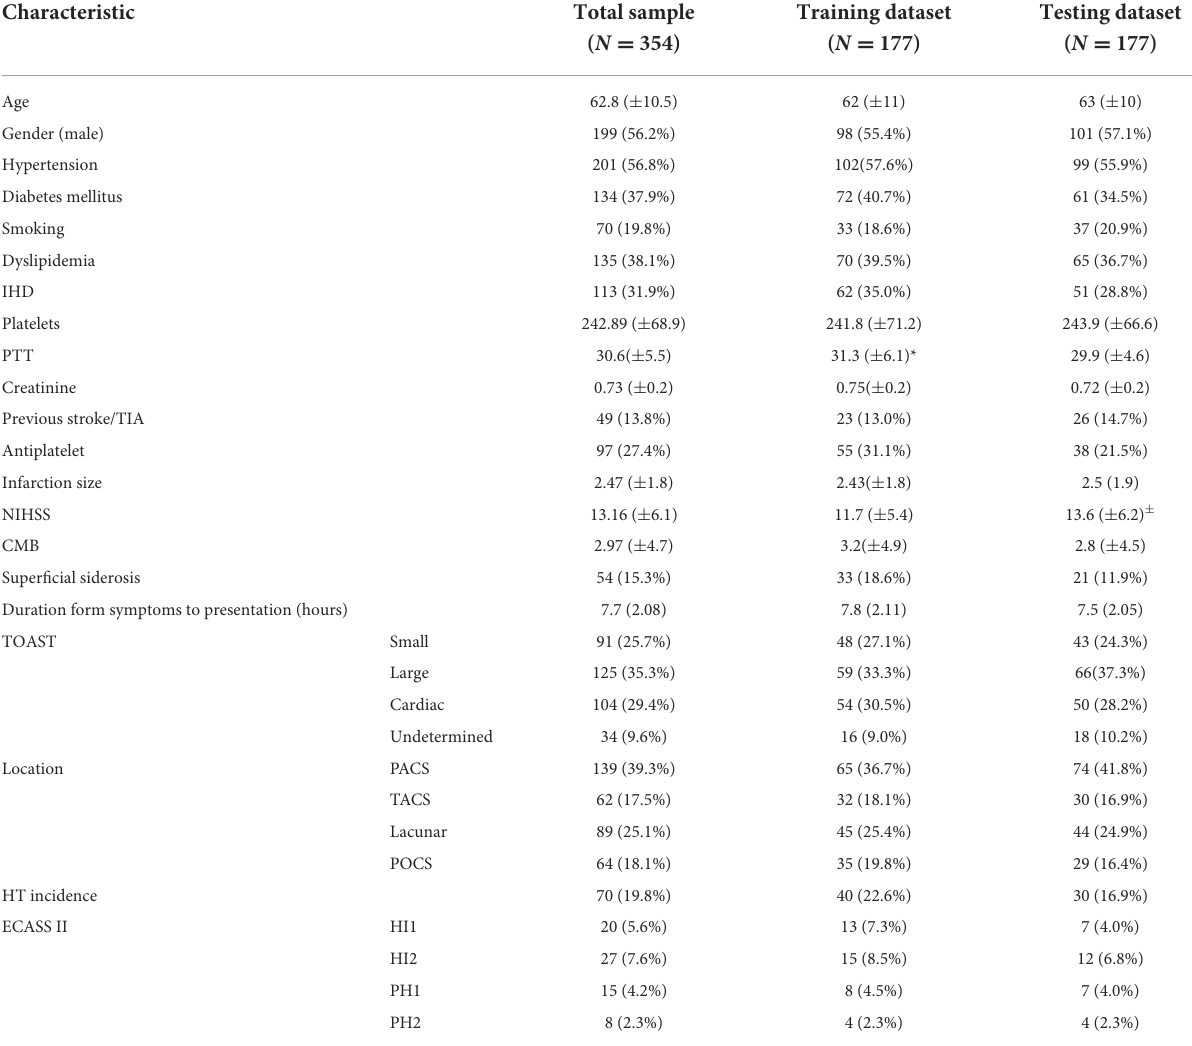
TABLE 1 Baseline characteristics of patients with ischemic stroke in the total sample and the randomly divided subgroups, the training and testing datasets.